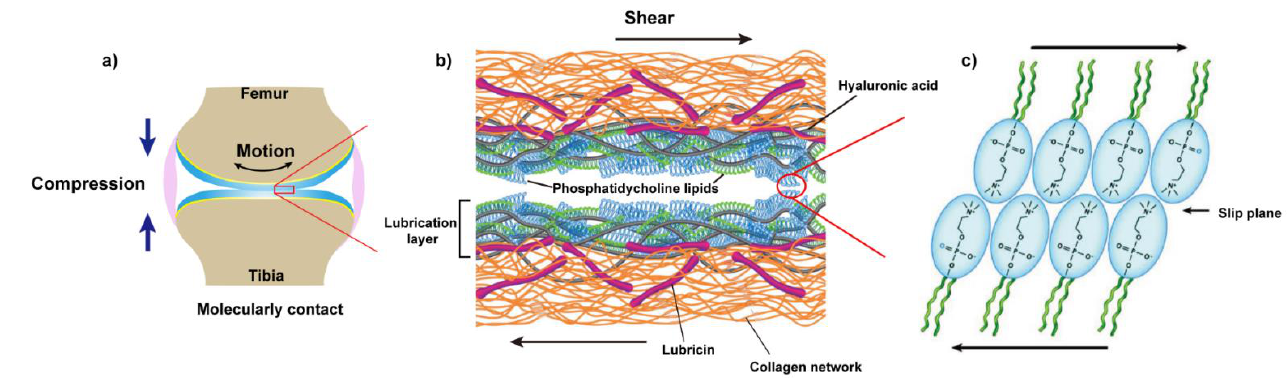
Figure 3. The schematic of boundary lubrication of articular cartilage. ( a ) Under high pressure, the outer surfaces of opposing articular cartilage were molecularly contacted. ( b ) The proposed structure of the lubrication layer on the outer surface of cartilage, exposing the phosphocholine groups of lipids at the interface to reduce friction via the hydration mechanism (Reprinted with permission from ref. [87]. Copyright 2016 Annual Reviews INC); ( c ) Representation of the phospholipids at the interface of opposing cartilage. Plane ( c ), Reprinted with permission from ref. [90]. Copyright 2015 American Chemical Society.